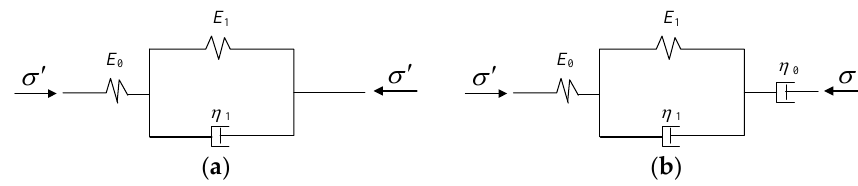
Figure 10. Schematic diagram of rheological model ( a ): three-element rheological model, ( b ) Four-element rheological model. where E 0 and E 1 are the moduli of the independent spring and the spring of the Kelvin–Voigt body, respectively; η 0 and η 1 are the viscosity coe ffi cient of the independent dashpot and the dashpot of the Kelvin–Voigt body,